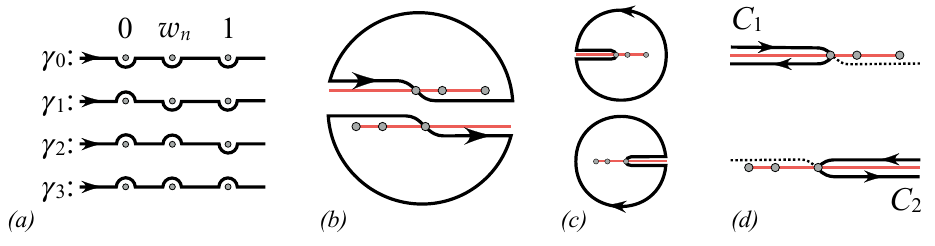
Figure 1 . (a) Contours for the Dotsenko-Fateev integral; (b) Closing γ 1 and γ 2 ; (c) Deformation; (d) Final contours (ignoring circles at infinity). Red lines indicate branching